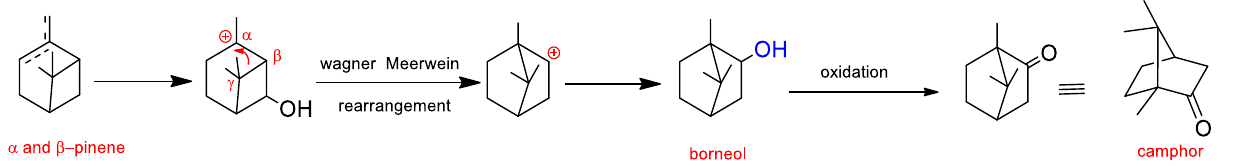
Figure 1. Hypothetic biosynthesis pathway explaining the formation of camphor content via unstable bicyclic monoterpenes (pinene).